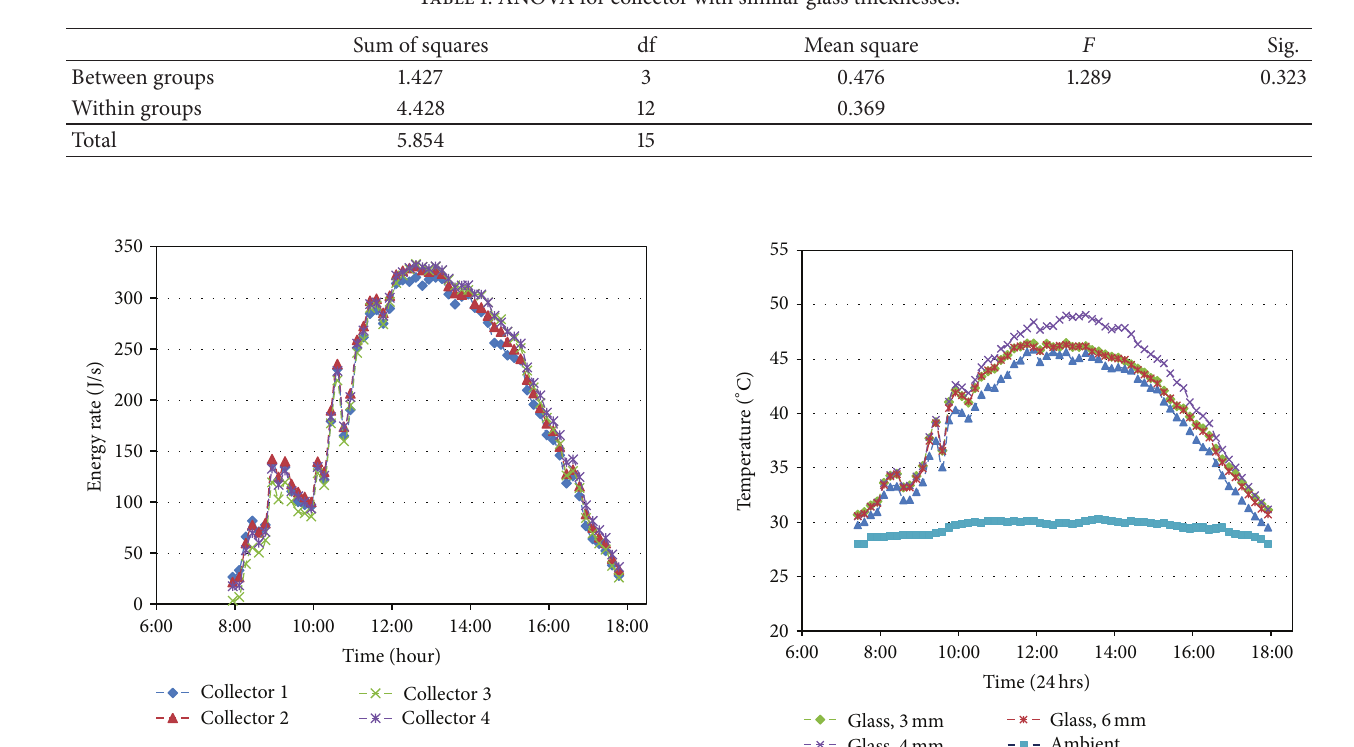
Figure 3: Energy profile of collector with similar glazing thickness.